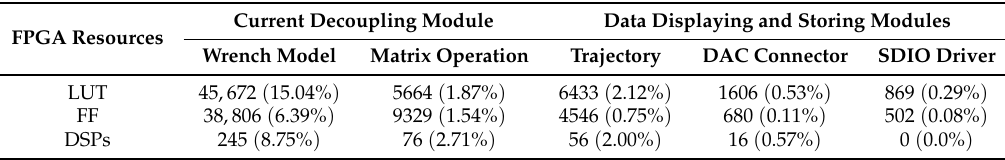
Table 4. FPGA resource utilization for hardware implementation. DPSs—digital signal processors; FF—Flip Flop; LUT— look-up